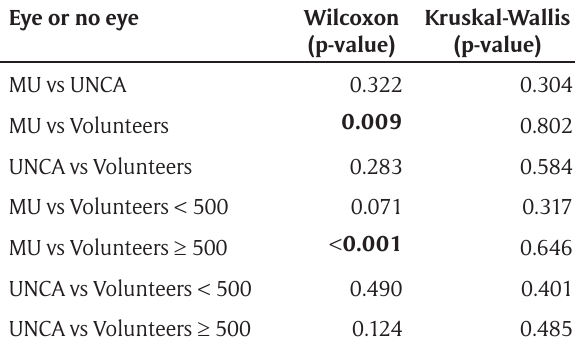
Table 3: Wilcoxon (mean) and Kruskal-Wallis (variance) test results for eye or no eye. Significant results (at 95% level) are shown in bold.